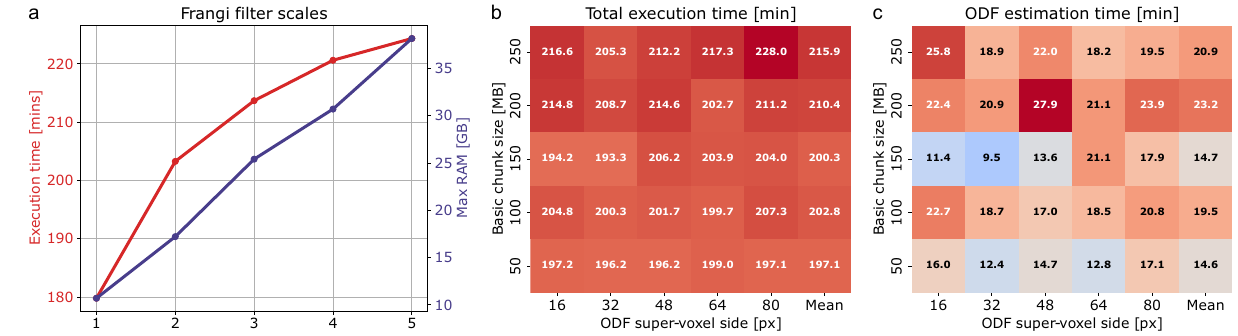
Figure 3. Runtime performance of the image processing pipeline: ( a ) execution times and memory usage of the Frangi-based fiber orientation analysis stage against the number of spatial scales of the Frangi filter ( σ = 1.25 µ m , image chunk size = 50 MB); ( b ) total execution time against different combinations of the spatial resolution of the fiber ODFs and the size of the basic image chunks analyzed iteratively ( σ = 1.25 µ m ); ( c ) fiber ODFs estimation time, against different configurations of the designed pipeline.